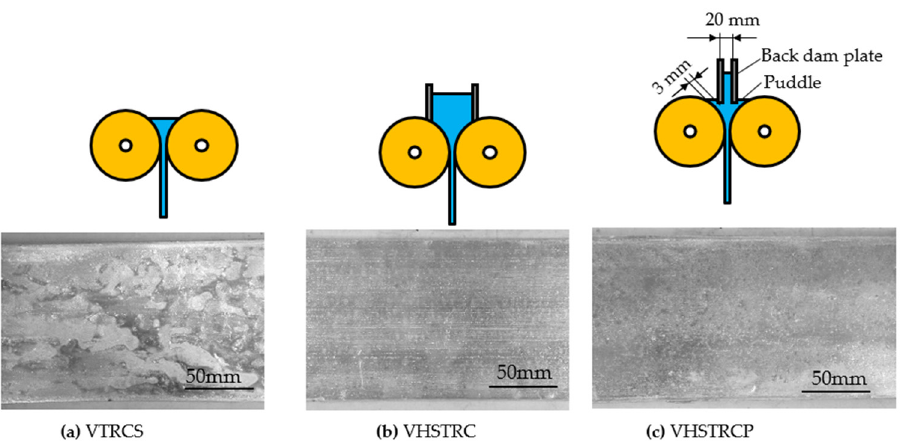
Figure 5. Effect of the back dam plate on the strip surface. Aluminum alloy: 6022, Roll speed: 60 m/min, Roll load: 0.14 kN/mm, Roll diameter: 300 mm, Roll width: 100 mm. Solidification length: 100 mm.